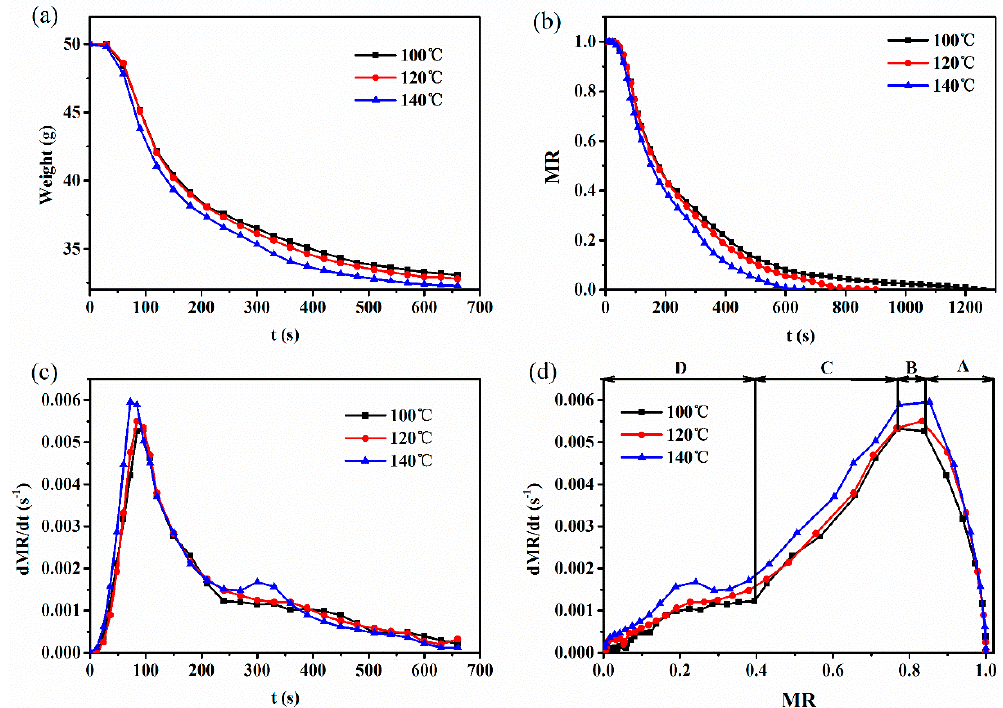
Figure 2. Drying curves of Zhaotong lignite at different temperature. ( a ) Mass loss vs. drying time; ( b ) moisture ratio vs. drying time; ( c ) drying rate vs. drying time; and ( d ) drying rate vs. moisture ratio.